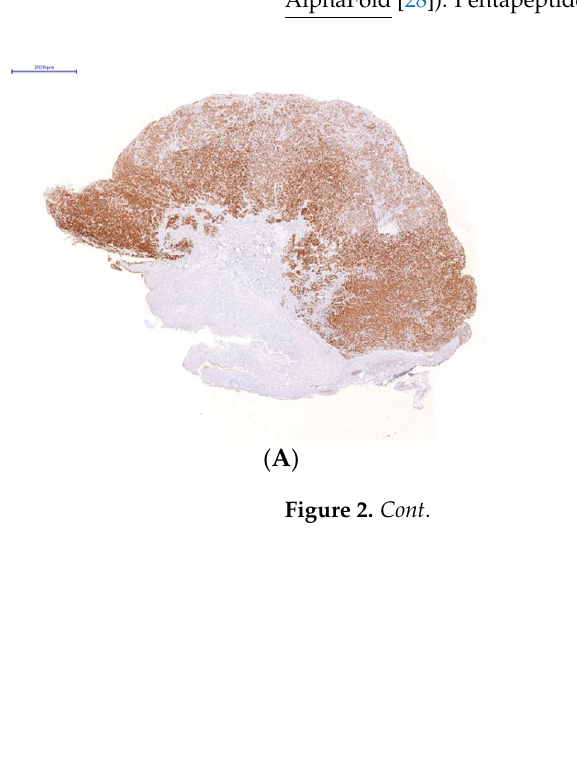
Figure 1. Location of pentapeptides shared with human endocrine autoantigens in 3-D structure spike glycoproteins of all Human Coronaviruses ( A – F ). (According to databases: PDB [27] and AlphaFold [28]). Pentapeptides are shown with grass-green.